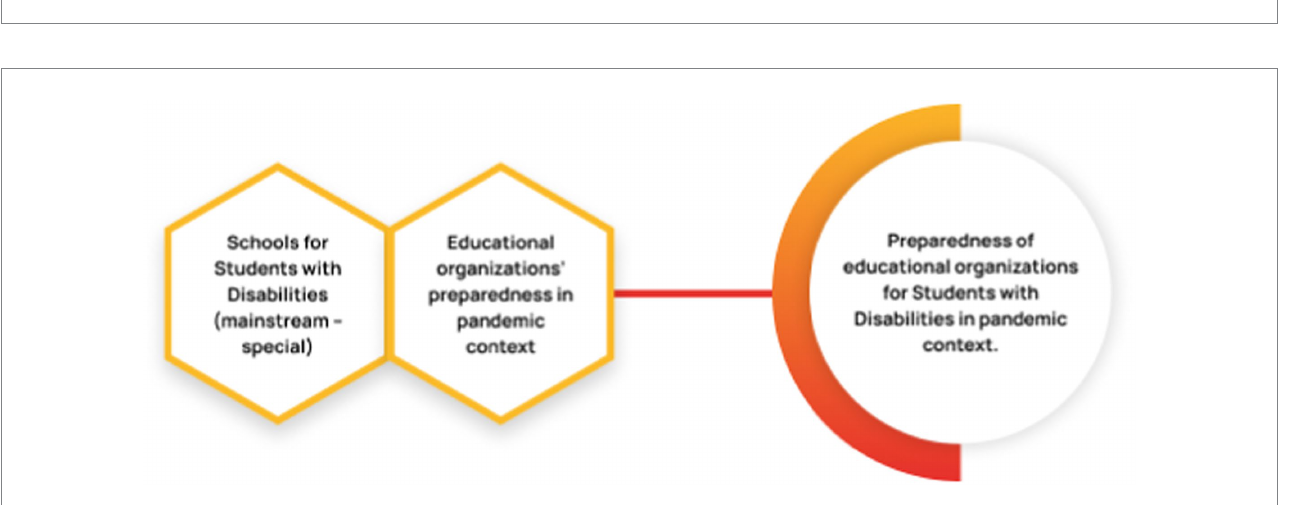
FIGURE 1 System thinking changes the framework of this study.